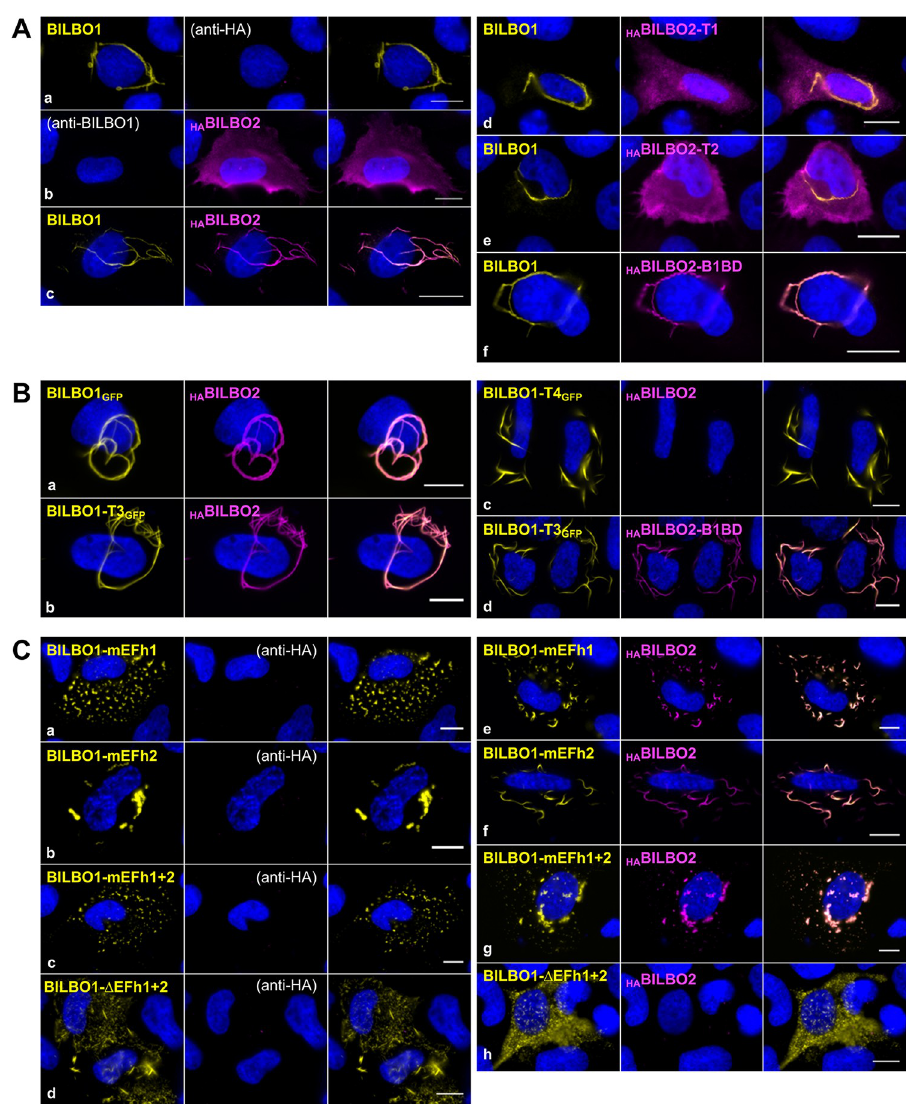
Fig 2. Analysis of BILBO1 and BILBO2 interaction in a heterologous system. A. U-2 OS whole cells expressing BILBO1 (a), HA BILBO2 (b), or co-expressing BILBO1 with HA BILBO2 (c) or with HA BILBO2-T1 (d), T2 (e), BILBO2-B1BD (f) domains, and processed for immunofluorescence. B . Immunolabeling on detergent-extracted U-2 OS cells co-expressing HA BILBO2 and BILBO1 GFP (a), BILBO1-T3 GFP (b), BILBO1-T4 GFP (c), and BILBO1-T3 GFP with HA BILBO2-B1BD (d). C. Immunolabeling on detergent-extracted U-2 OS cells expressing BILBO1 mutated on the EF- hands (mEFh1, mEFh2, mEFH1+2, a-c), deleted of the Efh1+2 domain (d), and co-expressed with HA BILBO2 (e-h). Scale bars, 10 μ